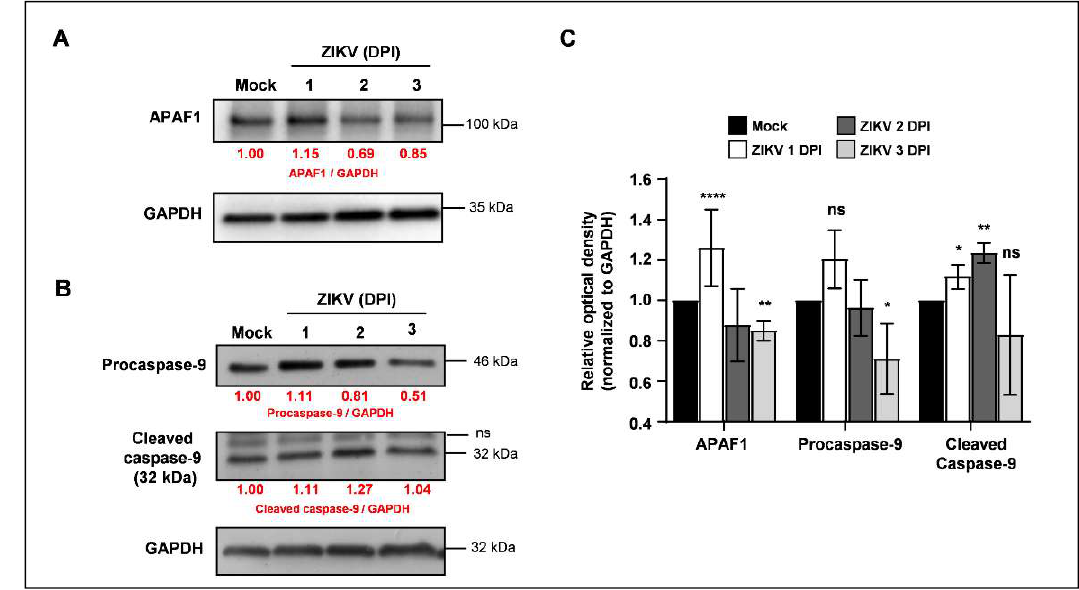
Figure 3. ZIKV infection triggers intrinsic apoptotic pathway. Mock- and ZIKV-infected (MOI 5) SH-SY5Y cells were harvested at the indicated timepoints and processed for immunoblotting analysis. Membranes were labeled with ( A ) anti-APAF1, ( B ) anti-caspase-9, and anti-GAPDH primary antibodies and appropriate HRP-conjugated secondary antibodies. Values in red show protein fold-change relative to mock-infected samples. Densitometry values were normalized to GAPDH before expression analysis. kDa—kilodaltons. ( C ) Relative quantification of densitometry analysis. Values are represented as mean ± S.D. Data representative of three independent experiments performed in triplicate. * p < 0.05, ** p < 0.01, **** p < 0.0001, ns—not significant, according to unpaired t -test compared to mock-infected.